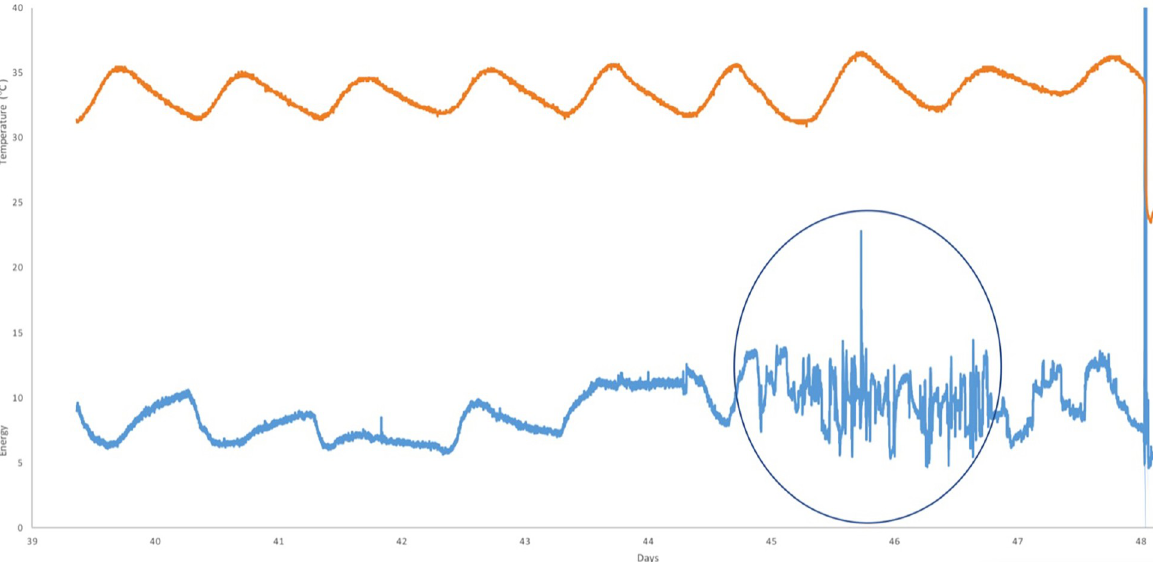
Fig 6. Detecting hatching events using TurtleSense. TurtleSense was used to monitor this relocated Olive Ridley ( Lepidochelys olivacea) nest in Ostional, Costa Rica. The sensor was placed when the nest was relocated on Day 0, and the communication unit was connected to the sensor at Day 39. Temperature data (top line) and accelerometer readings (bottom line) were recorded. Pipping was observed on Day 44 at 1900 via video footage within the nest and clearly matches documented accelerometer data collected by the embedded sensor. In this particular nest, hatching occurred over a 2.1 day period (Day 44.7–46.8; Circle indicates hatching activity). After a period of quiet (approximately 1 day), a trickle emergence was documented late on Day 47 (beginning at 19:20).